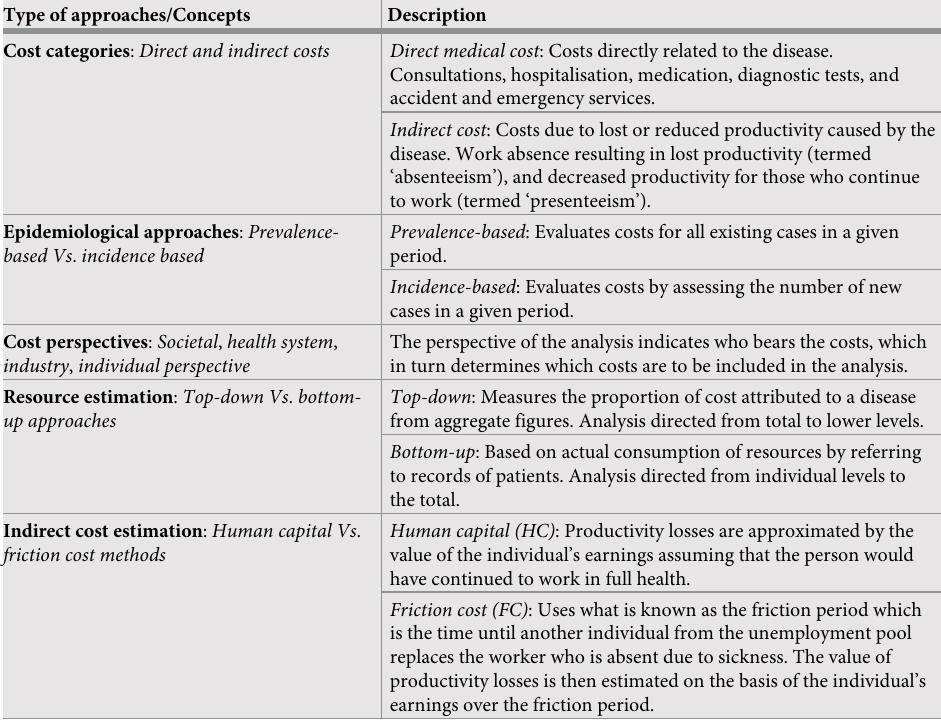
Table 3. Main concepts and approaches used in COI